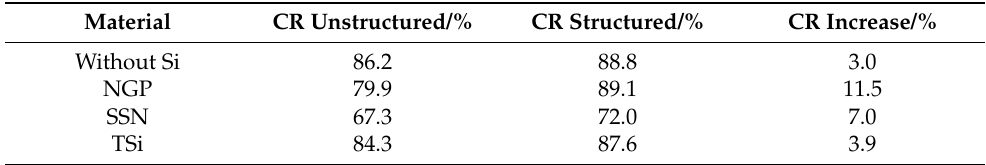
Table 7. Capacity retention (CR) of the pouch cells with unstructured and structured anodes at C/5, calculated with the first five cycles at C/5 and the last five cycles at C/5.